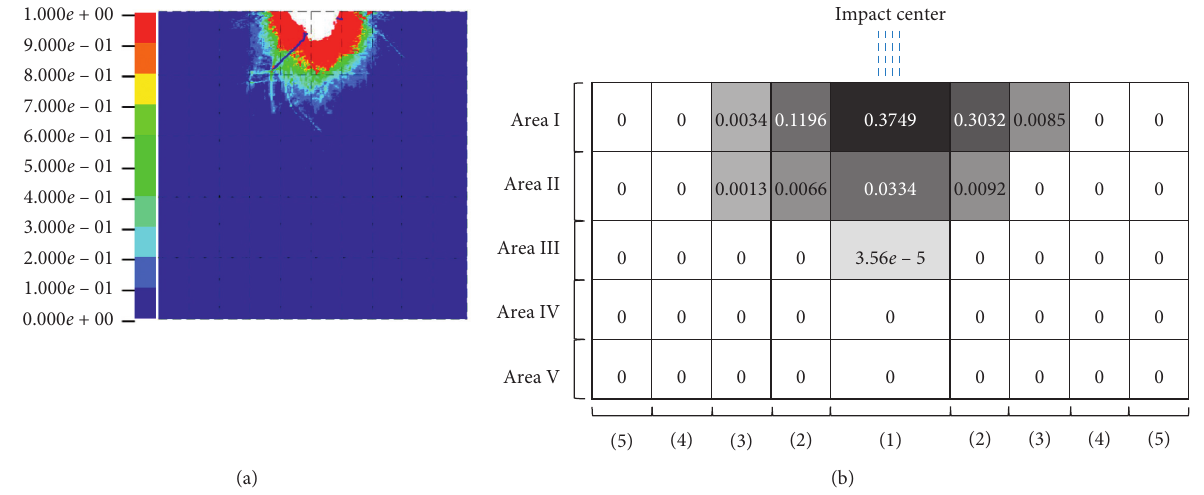
Figure 9: Distributions of comprehensive damage factors in each part of SFRC.